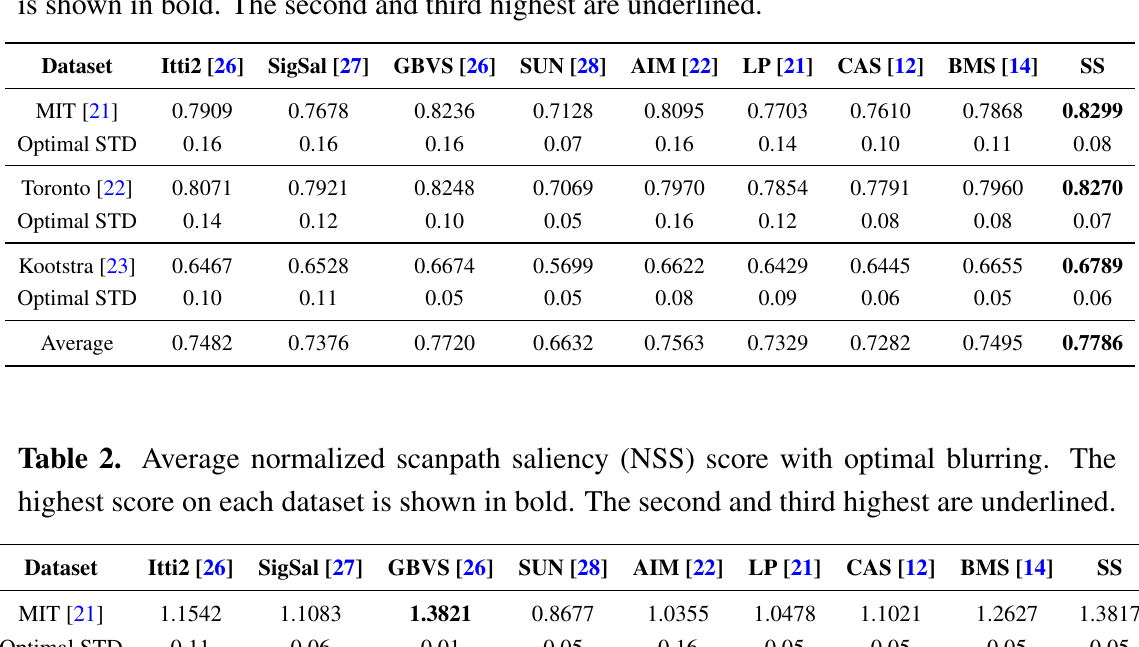
Table 1. Average AUC-Borji score with optimal blurring. The highest score on each dataset is shown in bold. The second and third highest are underlined.